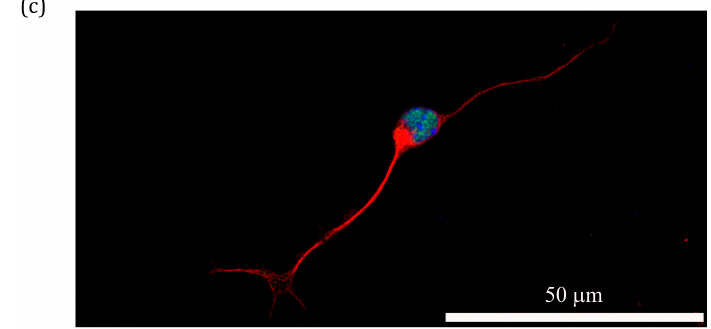
Figure 9. ( a ) Immunofluorescent staining of iPSCs carrying BDNF, tropomysin-related kinase B (TrkB), neurofilament heavy polypeptide (NF H) and Nestin with prior exposure to hypoxia at day 2 after transfection with PS80 PBCA NC (30 µ g/mL), HRE-cmvBDNF (2 µ g/mL) or PS80 PBCA NC/HRE-cmvBDNF (30 µ g/mL:2 µ g/mL; r = 15:1). The control and PS80 PBCA NC-treated cells displayed minimal fluorescent intensities for BDNF, TrkB, NF H and Nestin, by contrast the expression levels were higher in those treated with HRE-cmvBDNF and PS80 PBCA NC/HRE-cmvBDNF. The cells of PS80 PBCA NC/HRE-cmvBDNF appeared more loosely packed and spread out, and the expression of NF H and Nestin appeared more homogenous. ( b ) Immunofluorescent staining of iPSCs carrying NF H, Nestin, neuronal nuclei (NeuN) and beta III tubulin at day 7 after transfection with PS80 PBCA NC, HRE-cmvBDNF or PS80 PBCA NC/HRE-cmvBDNF. The fluorescent signals were weak for the control and PS80 PBCA NC-treated cells, neural differentiation was scant and ineffective, by contrast, HRE-cmvBDNF-treated cells showed a stronger signal intensity for all the markers of neural differentiation, and cells of neuron-like morphology were identified. PS80 PBCA NC/HRE-cmvBDNF-treated cells predominantly expressed late marker of neural differentiation such as NF H; the morphological changes were distinctively neuron-like. ( c ) An enlarged view of the PS80 PBCA NC/HRE-cmvBDNF-treated cell tripled stained with NeuN, beta III tubulin and 4 (cid:48) ,6-diamidino-2-phenylindole (DAPI) showing a bipolar morphology with an enlarged cell body, elongated axons and